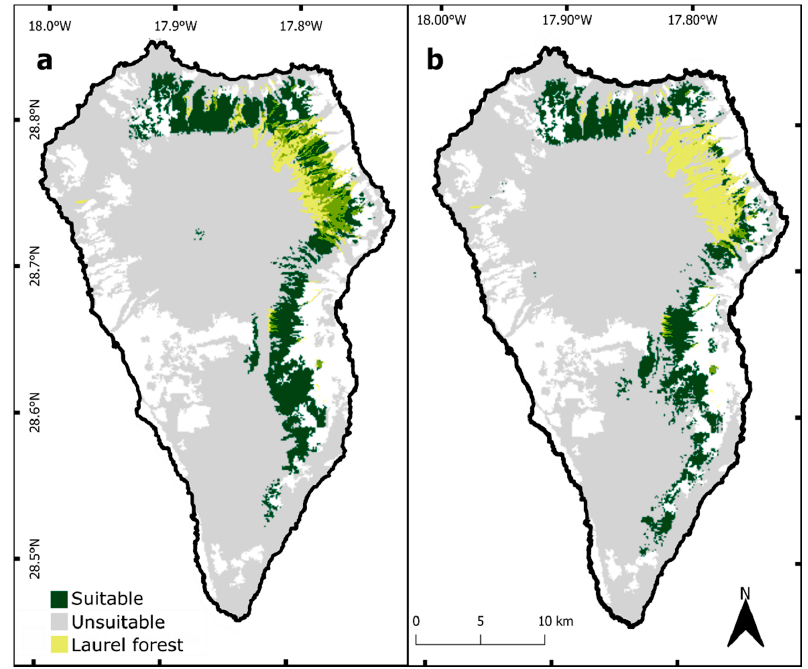
Figure 8. C. sativa binary habitat suitability maps from ( a ) the ensemble model (EM) based on the field-collected species occurrence locations, and from ( b ) the EM based on RS-derived species occurrence locations. These maps are the outcomes of the binary transformation of the predicted maps from the respective models. The extent of the laurel forest (based on the plant communities defined by Del Arco Aguilar et al. [63]) is indicated as a yellow semi-transparent